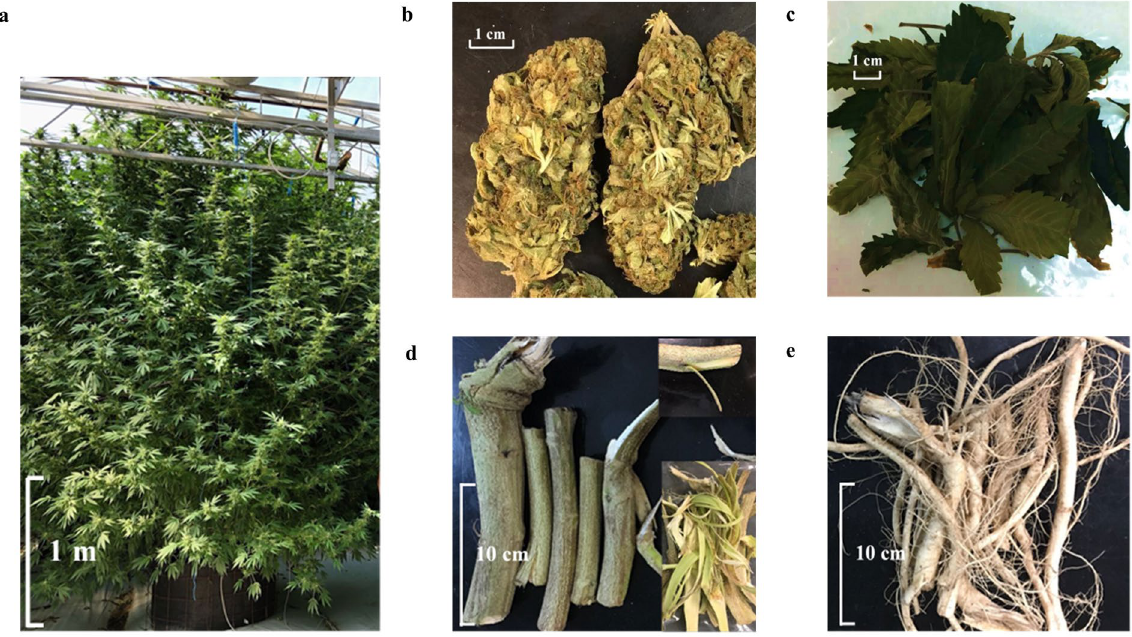
Figure 2. Cannabis CBD Mango Haze plant, inflorescences, leaves, root, stem barks, and roots. ( a ) CBD Mango Haze plant that has been kept in vegetative stage for six months and initiated flowering for two months in a greenhouse. ( b ) Dried cannabis inflorescences. ( c ) Dried cannabis leaves. ( d ) Fresh cannabis stems with barks and later peeled (right corner). ( e ) Fresh root